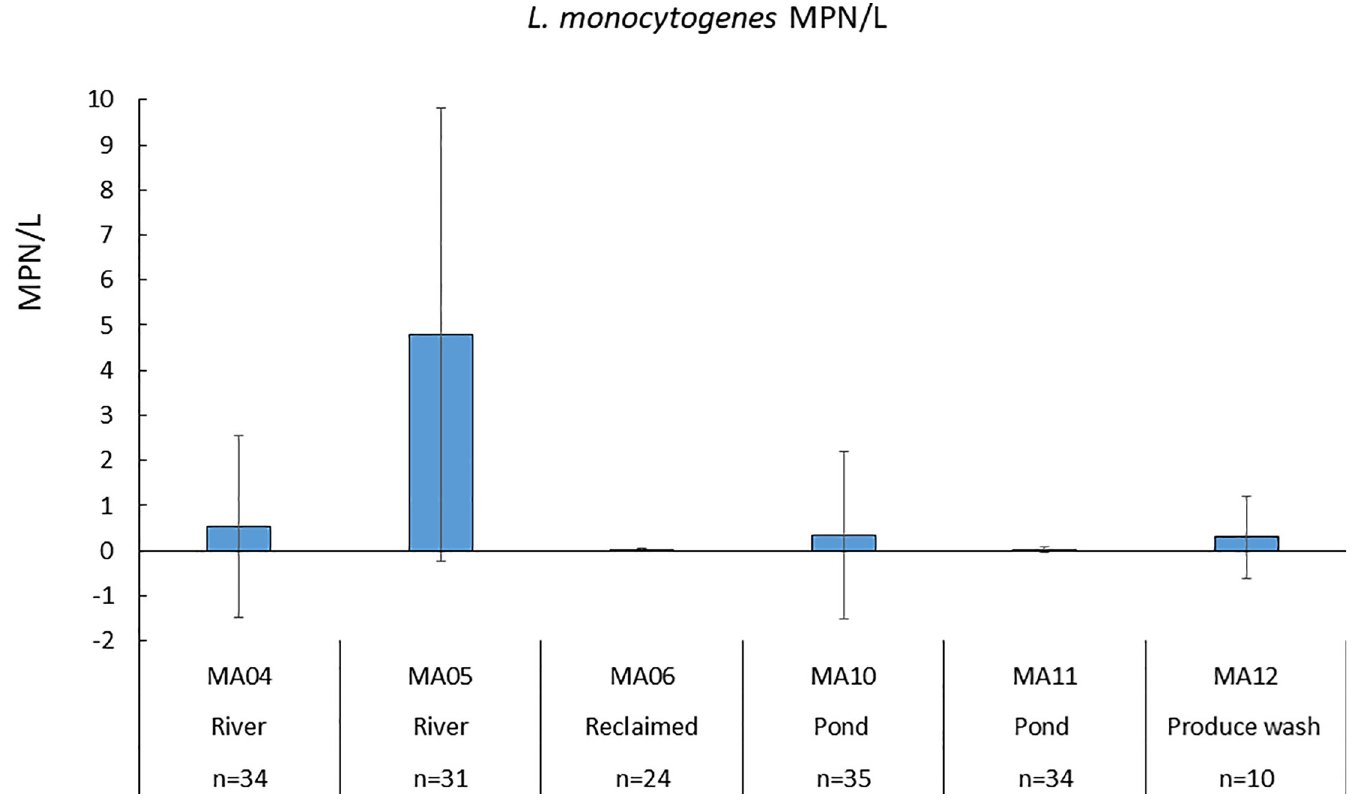
Fig 3. Mean MPN/L values for L . monocytogenes for all six sites (n = number of samples) where water samples were taken from Fall 2016–2018.